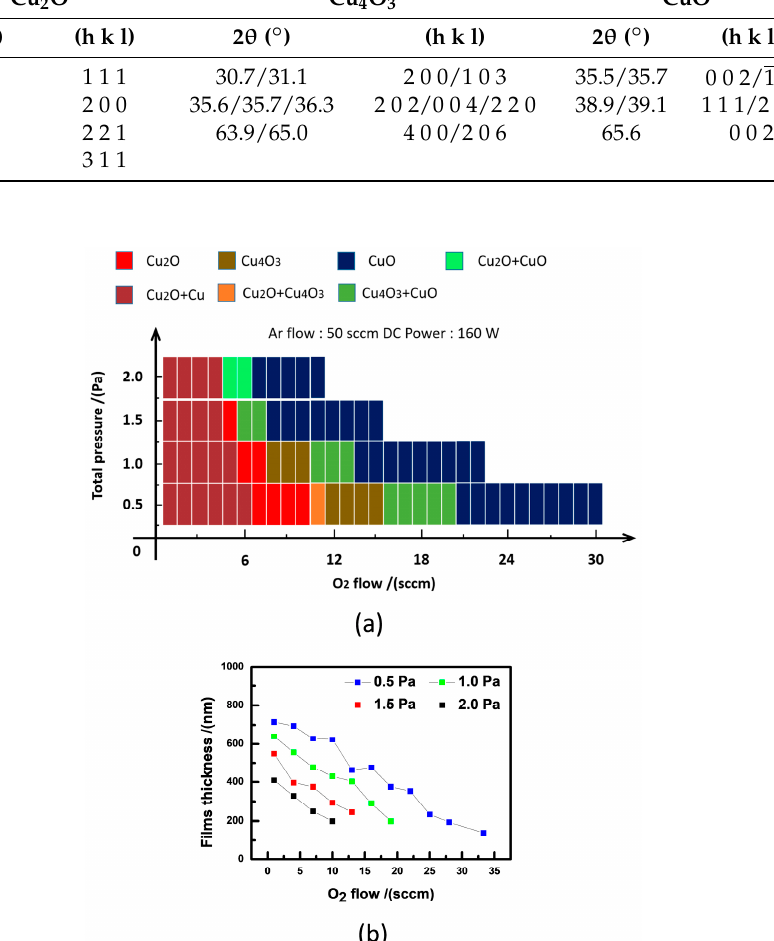
O 2 flow rate; ( b ) film thickness prepared under different